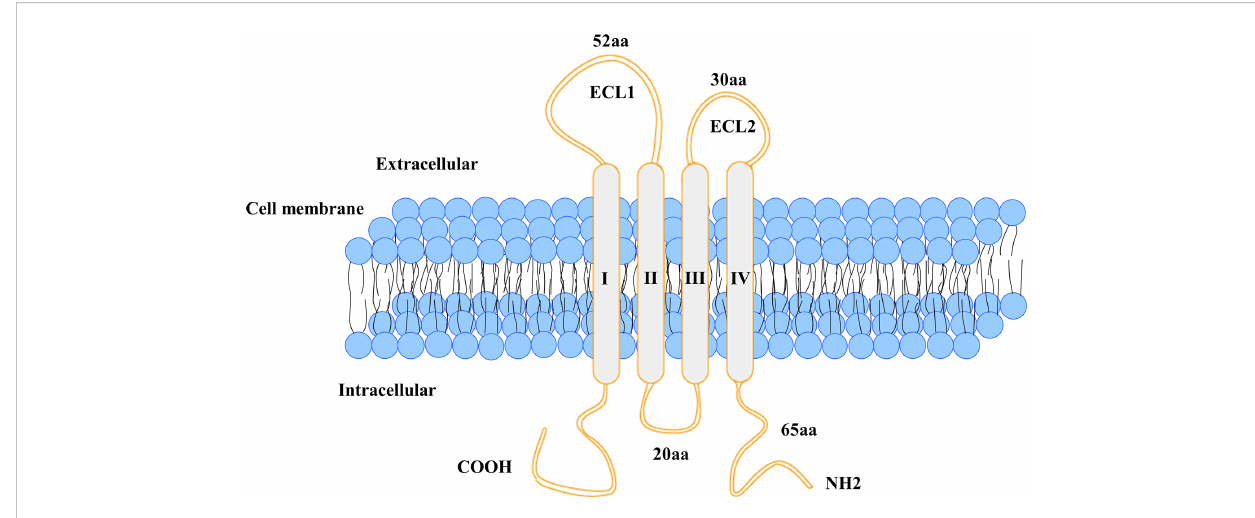
FIGURE 1 Schematic structure of CLDN18